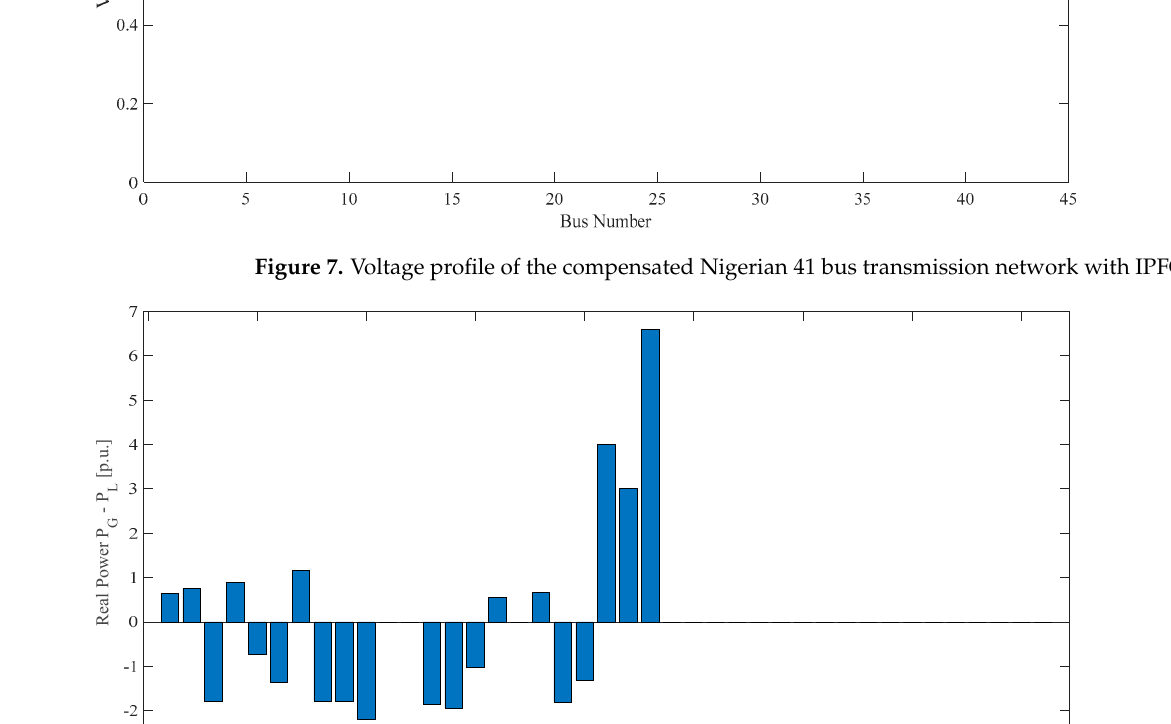
Figure 8. Real power output of the compensated Nigerian 41 bus transmission network with IPFC.